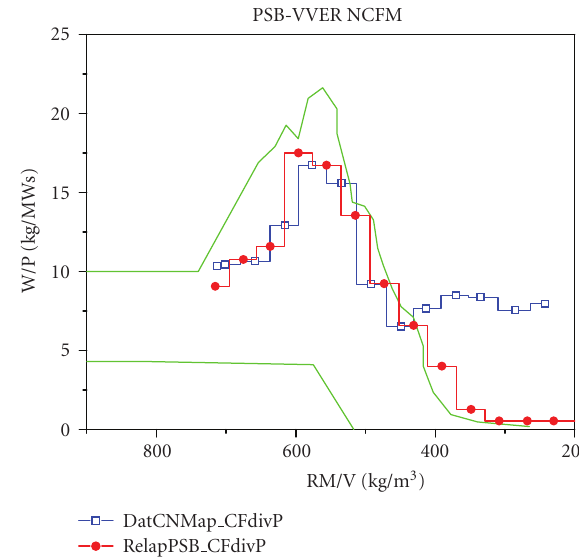
Figure 4: Natural circulation map for Atucha-I at di ff erent core power level and in case of SBLOCA.